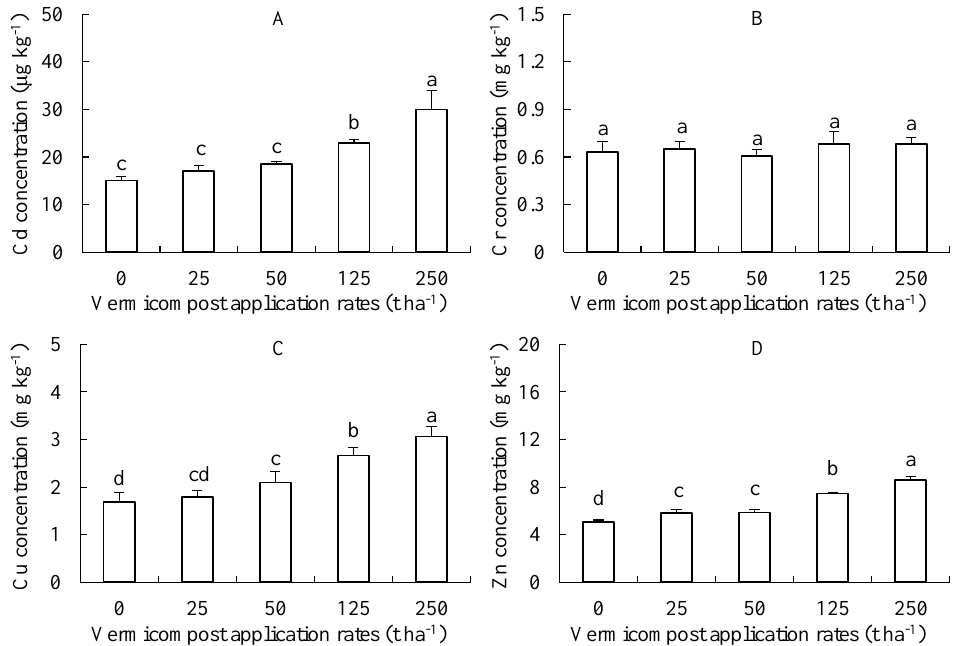
Figure 4. Effects of vermicompost application on metal concentrations for Cd ( A ), Cr ( B ), Cu ( C ) and Zn ( D ) of barley grown in mudflat salt-affected soil. Values are the mean of three replicates, and bars show standard deviation. Columns with different letters show a significant difference between sewage sludge amendment rates at p < 0.05 by LSD’s multiple range test. Cd, cadmium; Cr, chromium; Cu, copper; Zn, zinc.